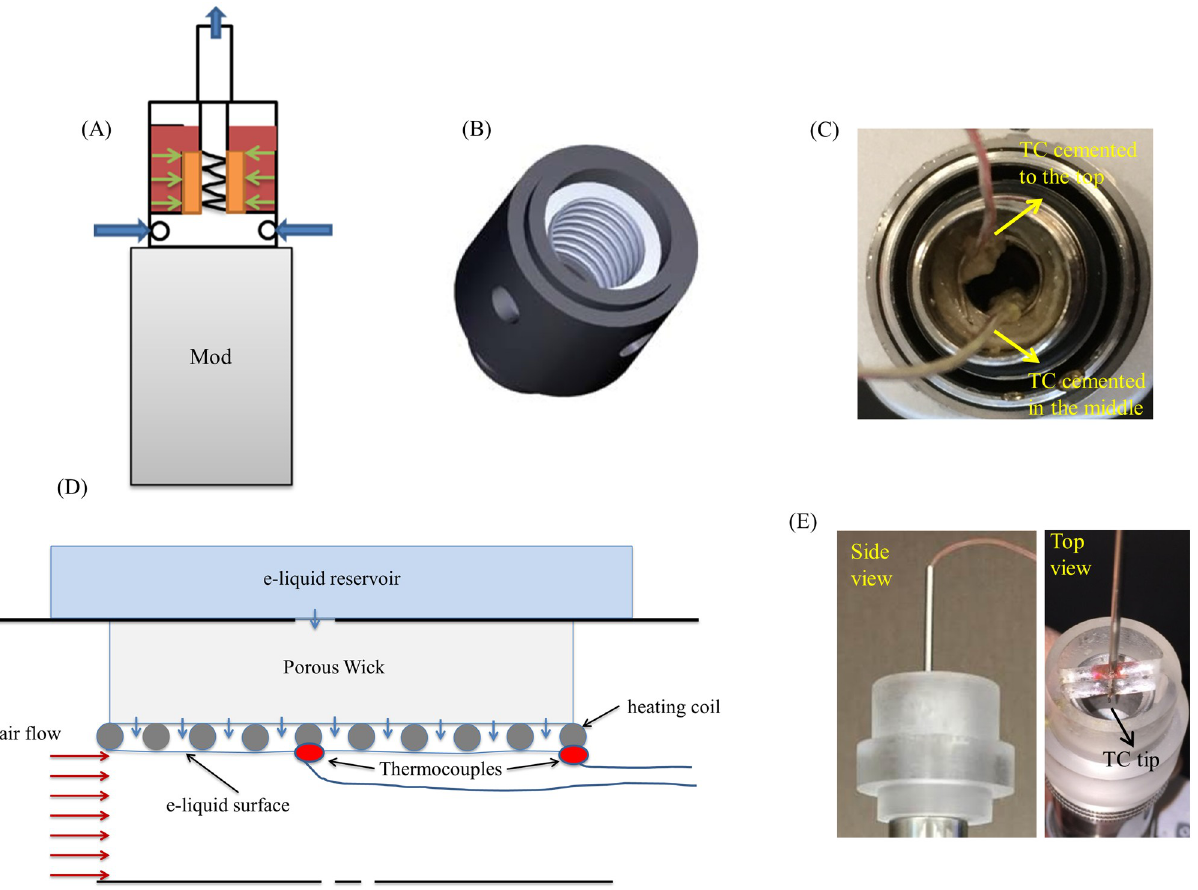
Fig 1. ENDS schematic and temperature measurement set up. (A) schematic of recent generation e-cigarette (blue arrows indicate air flow direction); (B) 3D drawing of internal atomizer with visible coiled wire heating element and central air flow channel. (C) Two thermocouples (TC) cemented to the top and middle sections of heating coil for measuring temperature; (D) Axisymmetric schematic view of typical atomizer configuration showing approximate locations of attached thermocouples. (E) A constructed fixture for measuring aerosol smoke temperature. The fixture holds the thermocouple in place in the center of the flow